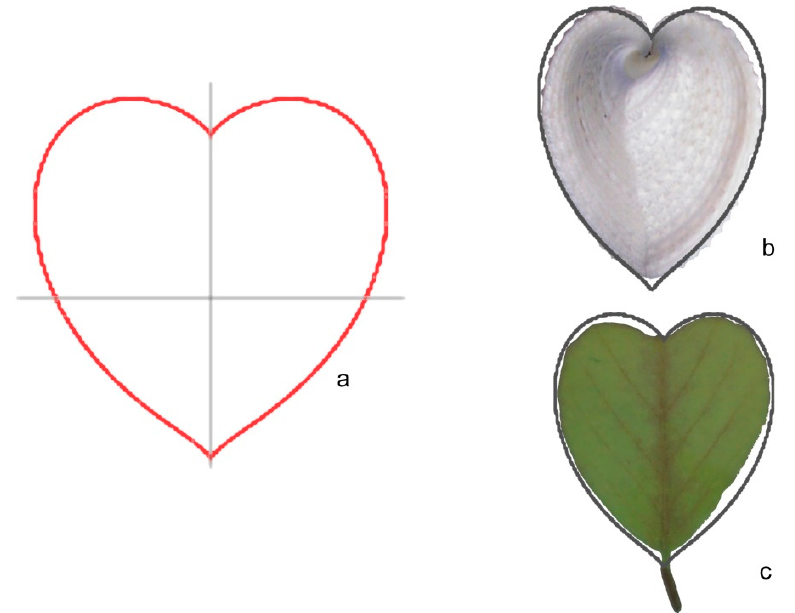
Figure 5. ( a ) Construction of a Fibonacci spiral. The Fibonacci spiral is observed in sea shells of the species Argonauta argo ( b ) as well as in the growth of some species of ferns ( c ).